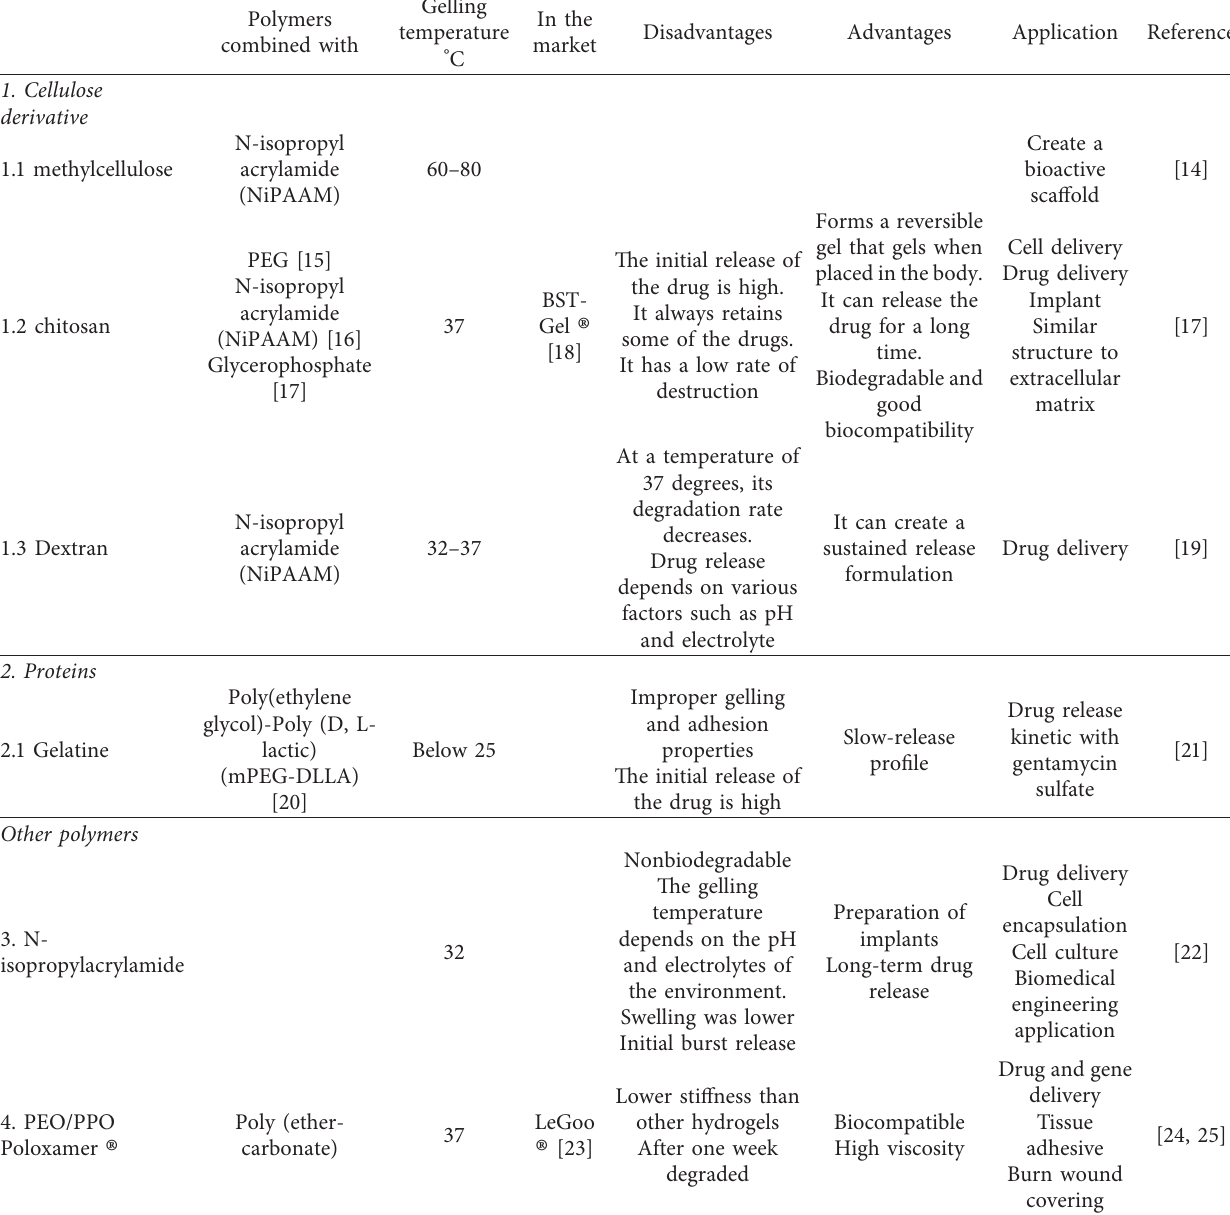
Table 1: Type of thermo-responsive